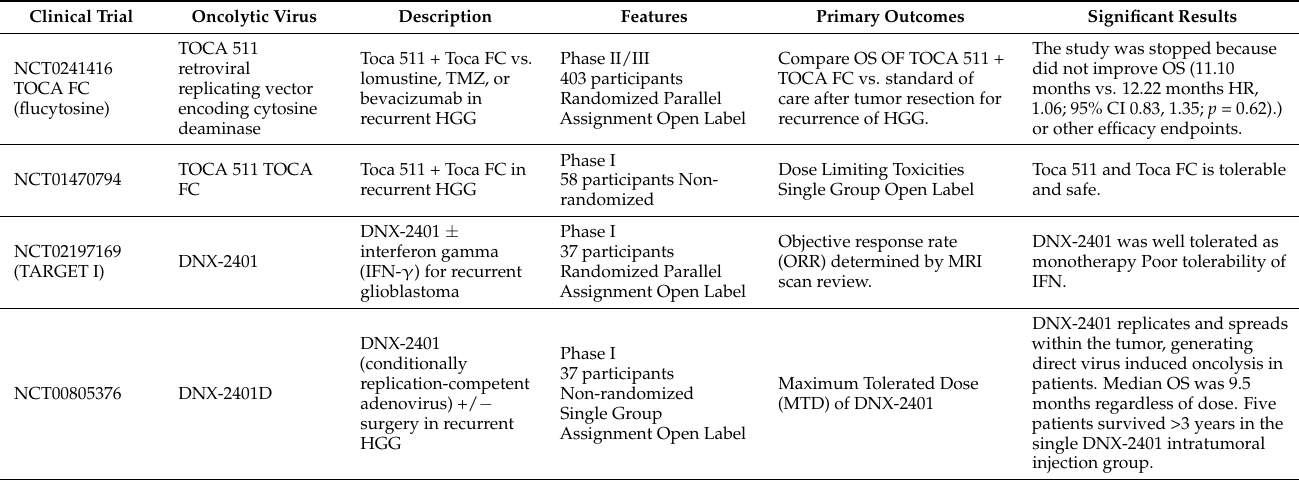
Table 2. Oncolytic Virus